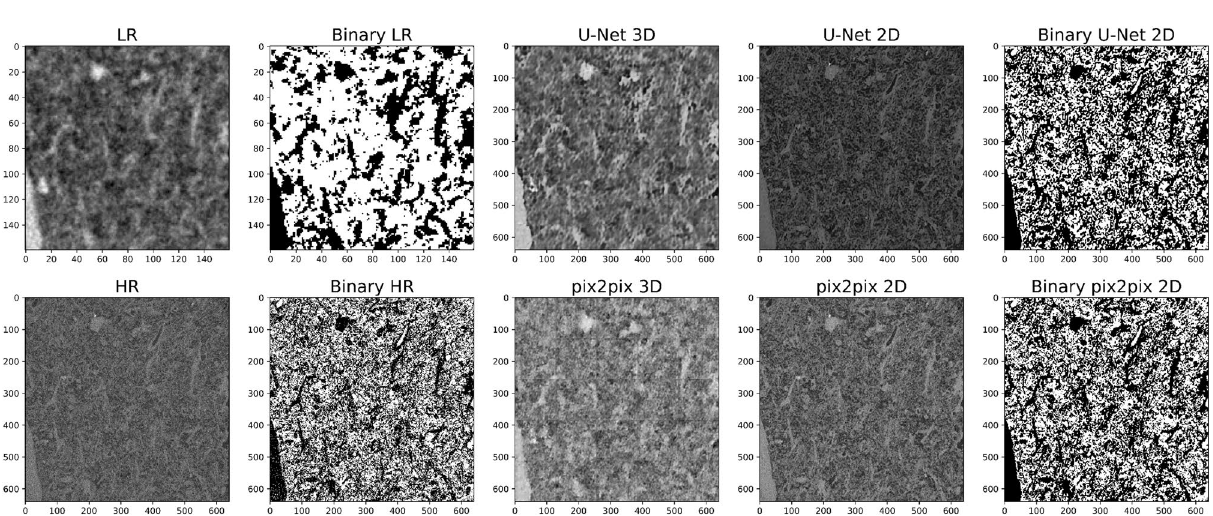
Figure 3. Super-resolved validation images: 2D networks trained on paired data. Validation slices for 2D CNNs (U-Net, SR-ResNet, EDSR, WDSR-a, WDSR-b) and GANs (pix2pix) employed for super-resolution imaging. LR (input) and HR (ground truth) images are also shown for comparison. Correspondent training details and image quality metrics are reported in Table 1.